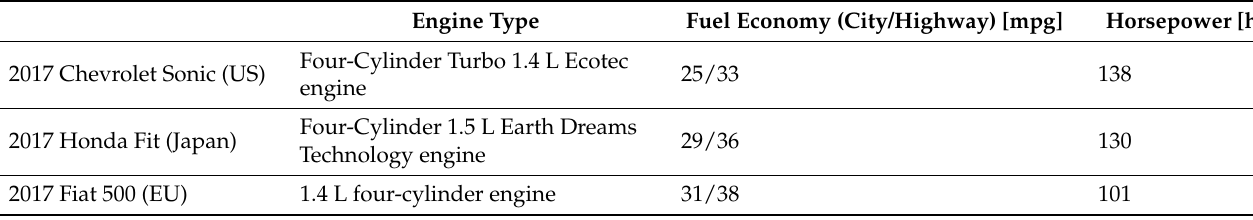
Figure 10. Four Cylinder Turbo 1.4 L Ecotec [62]. Table 1. The essential characteristics of various inline engines.